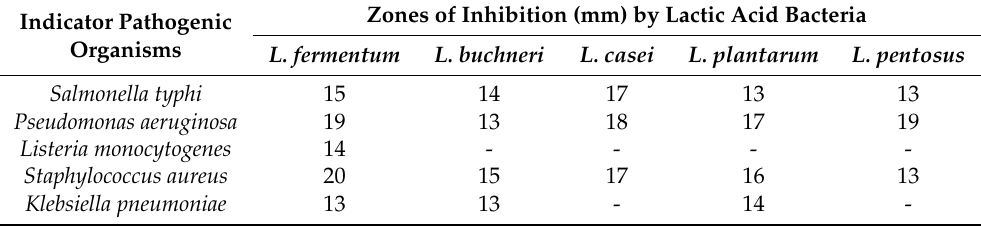
Table 3. Antagonistic activity of lactic acid bacteria against clinical pathogens.